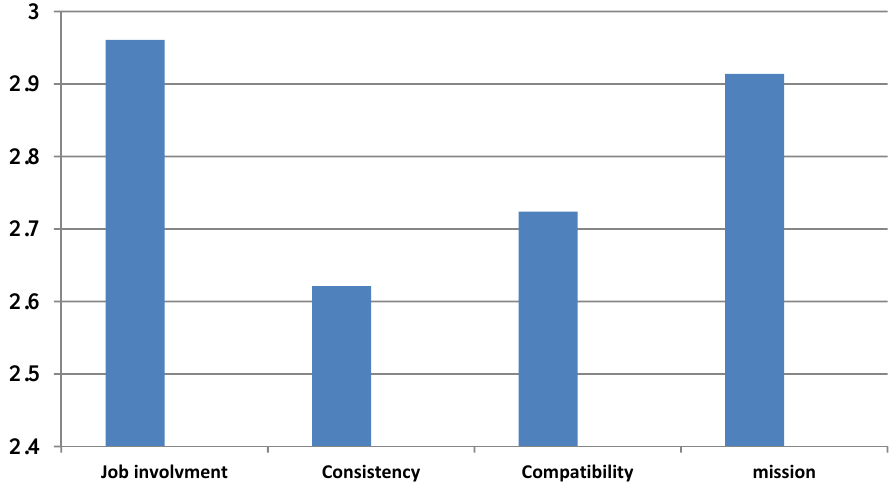
Fig. 2. The results of scores for the main components of the